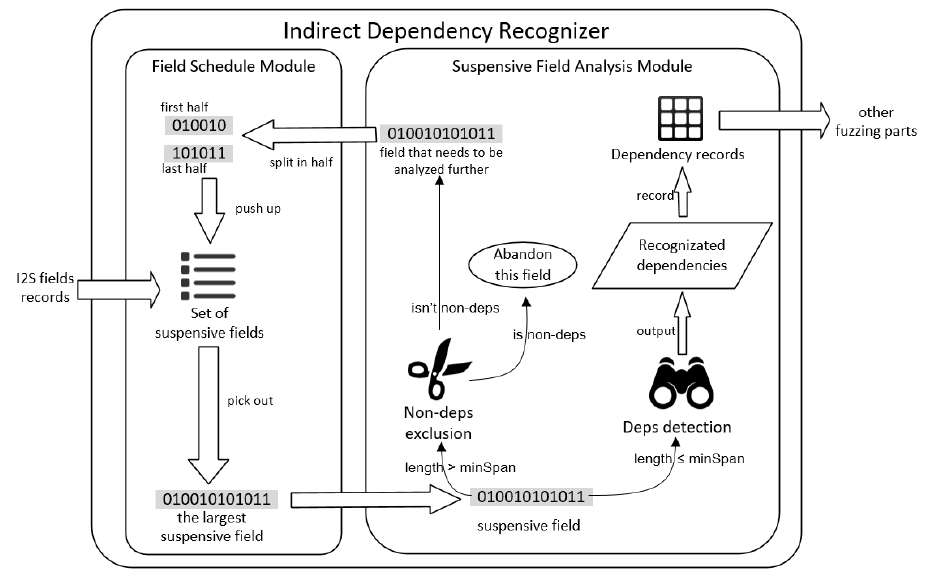
Figure 8. The overall design of Indirect Dependency Recognizer